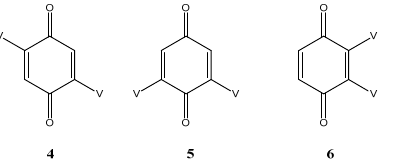
Figure 1. The three bis adducts of vindoline (V) and benzoquinone.